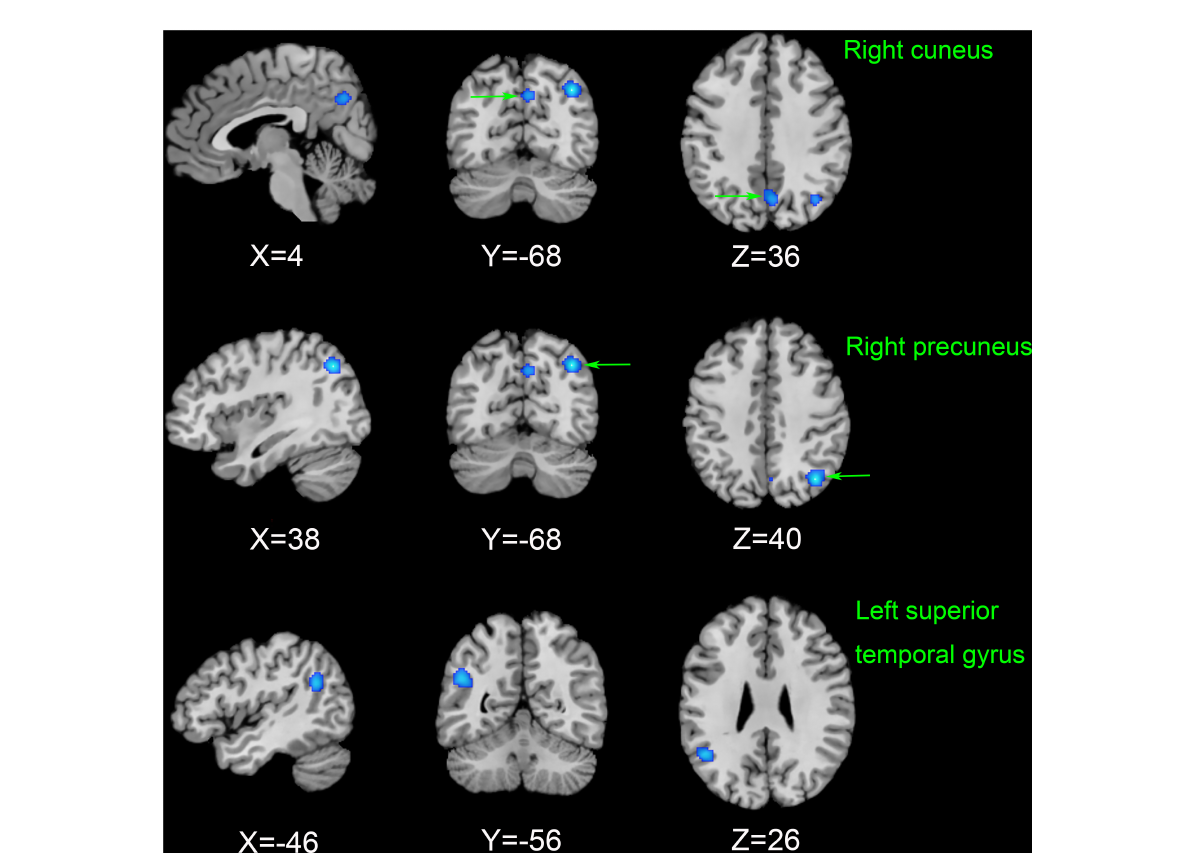
FIGURE3 The results of the meta-analysis of all 11 datasets compared the differences between ESRD dialysis patients and HCs. Areas of reduced ALFF/fALFF are shown in blue relative to HCs. The results reached the threshold at p < 0.001 cluster-corrected and p < 0.05 FWE corrected. ESRD, end-stage renal disease; HCs, healthy controls; ALFF, amplitude of low-frequency fluctuation; fALFF, fractional amplitude of low-frequency fluctuation; FWE, family-wise error.